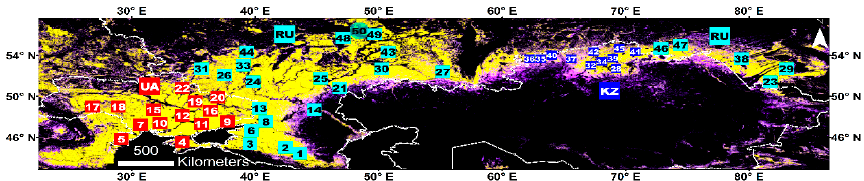
Figure 1. Land cover stability in Ukraine (UA), southern Russia (RU), and northern Kazakhstan (KZ) as revealed by International Geosphere Biosphere Programme (IGBP) global land cover classification scheme MODIS 0.05° cropland (IGBP class 12) land cover products for 2003–2010. For details on how the land cover stability analysis was conducted, please refer to [22,34]. In this figure, Yellow = stable core area; Magenta = unstable peripheral areas; Black = no occurrence of the given land cover class. Overlaid are the 49 specific cropland and one mixed forest (site 50—most northern site) study sites. The AMSR-E pixels are numbered from lower to higher latitude. Modified from [22]. Site names, latitudinal and longitudinal coordinates for all the study sites can be found in Table A1.